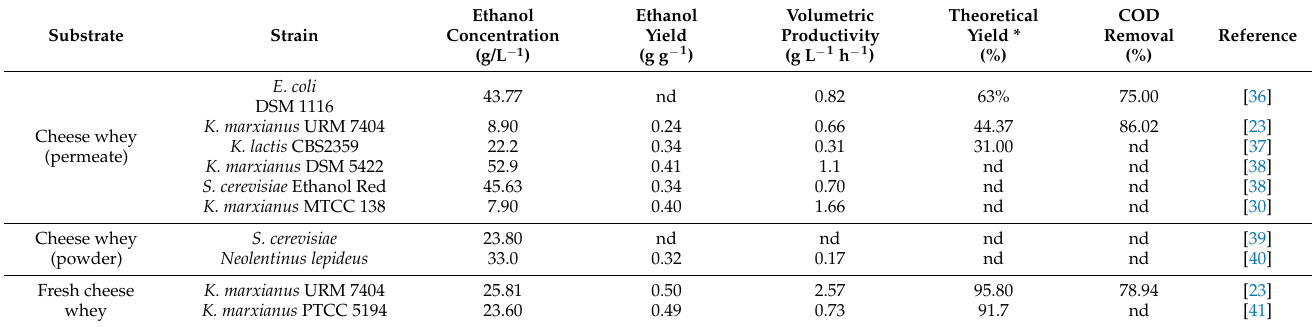
Table 2. Bioethanol production using different types of cheese whey as a